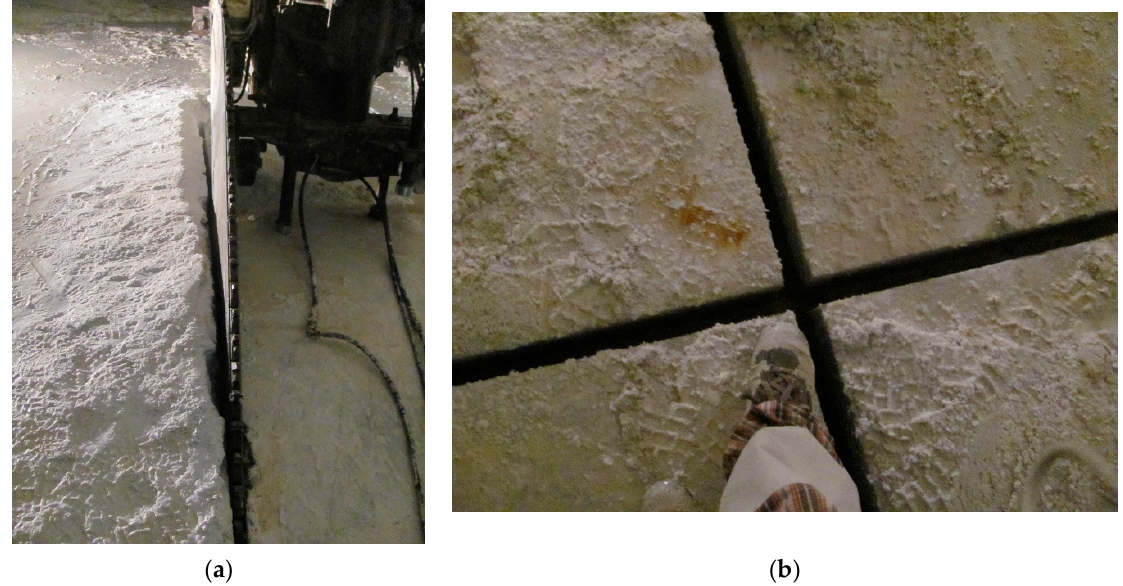
Figure 19. ( a ) A chain saw performing a vertical cut in Carrara marble; ( b ) very precise result of the isolation of blocks made by vertical cuts, perpendicular to one another, using the same technique. The thickness of the cut is ~40 mm.